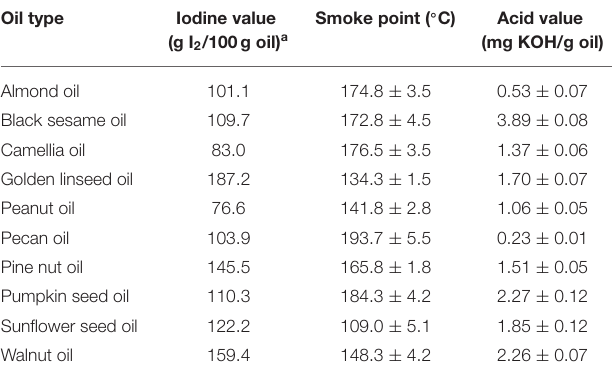
TABLE 2 | Smoke points, acid values, and iodine values of 10 expeller-pressed